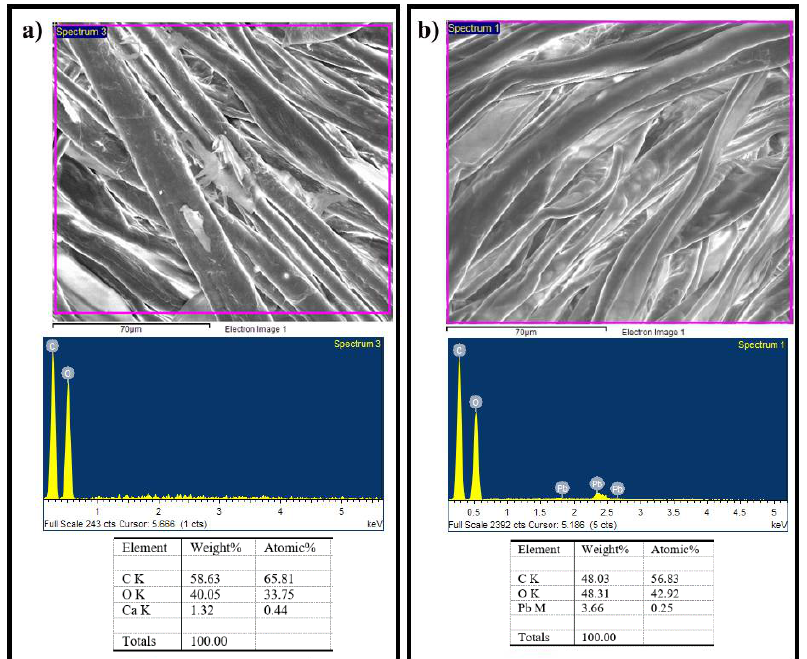
Figure 6. SEM images and EDS spectra for ( a ) cellulose and ( b ) Com-1 .